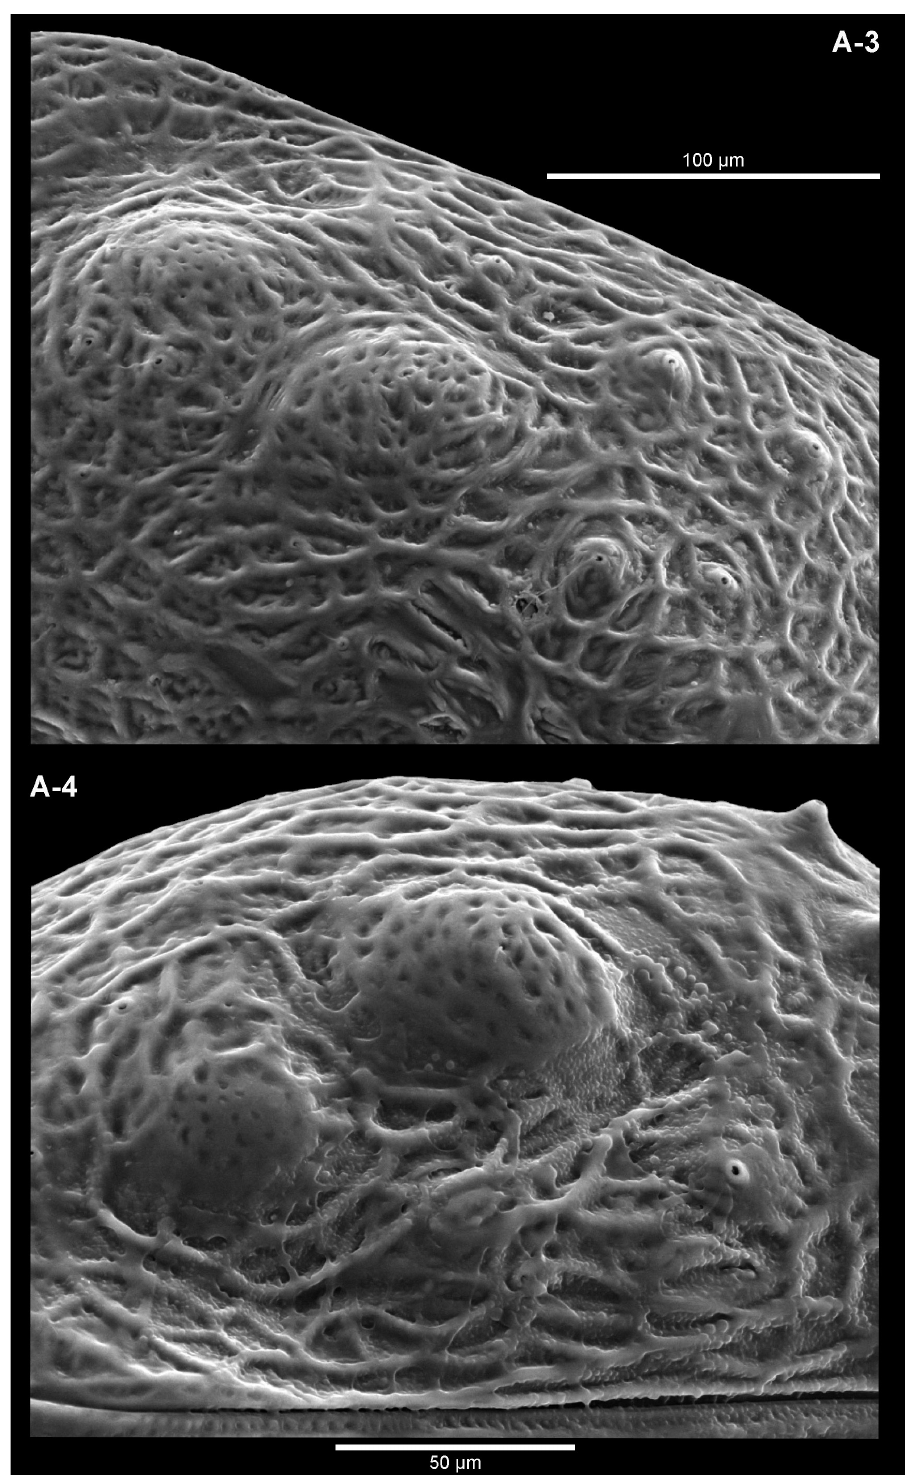
Fig. 21. Detailed views of carapaces of Bennelongia dedeckkeri Shearn et al ., 2012 from Lake Dunn to show the domes in both images and 4 cones in the top image of an A-3 specimen, and only one cone in the image of an A-4 specimen. Note the interlacing reticulation around the domes, and the small nodes coating the valves, with 2 different diameters best seen to the right of the largest dome. These nodules are thought to be part of the valve